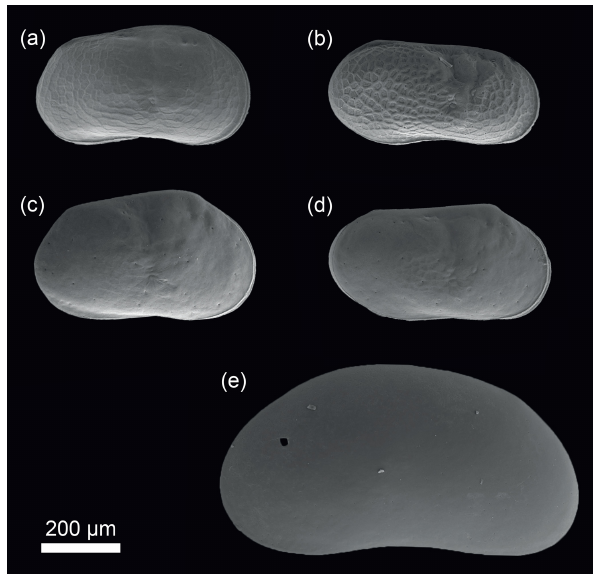
Figure 1. SEM photographs of the external lateral views of key species used in this study. (a) Female right valve Limnocythere in- opinata , (b) male right valve Limnocythere inopinata , (c) female right valve Limnocythere sp. A, (d) male right valve Limnocythere sp. A and (e) female left valve Candona